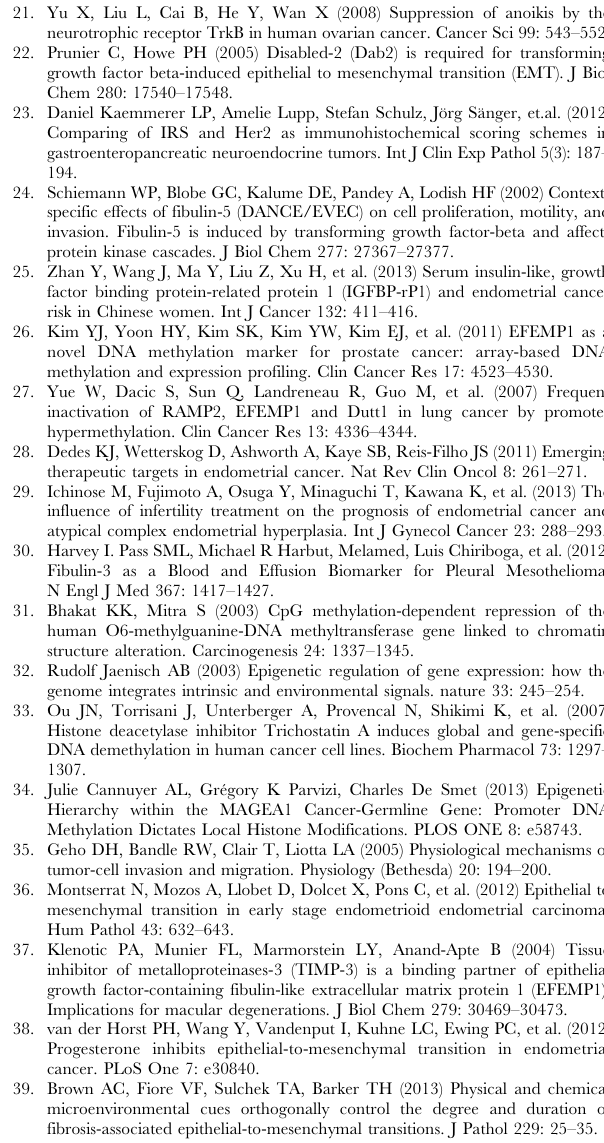
Table S1 Statistical difference EFEMP1 expression between aypical hyperplasia and endometrial carcinoma. Table S2 Statistical difference EFEMP1 expression between atypical hyperplasia and normal